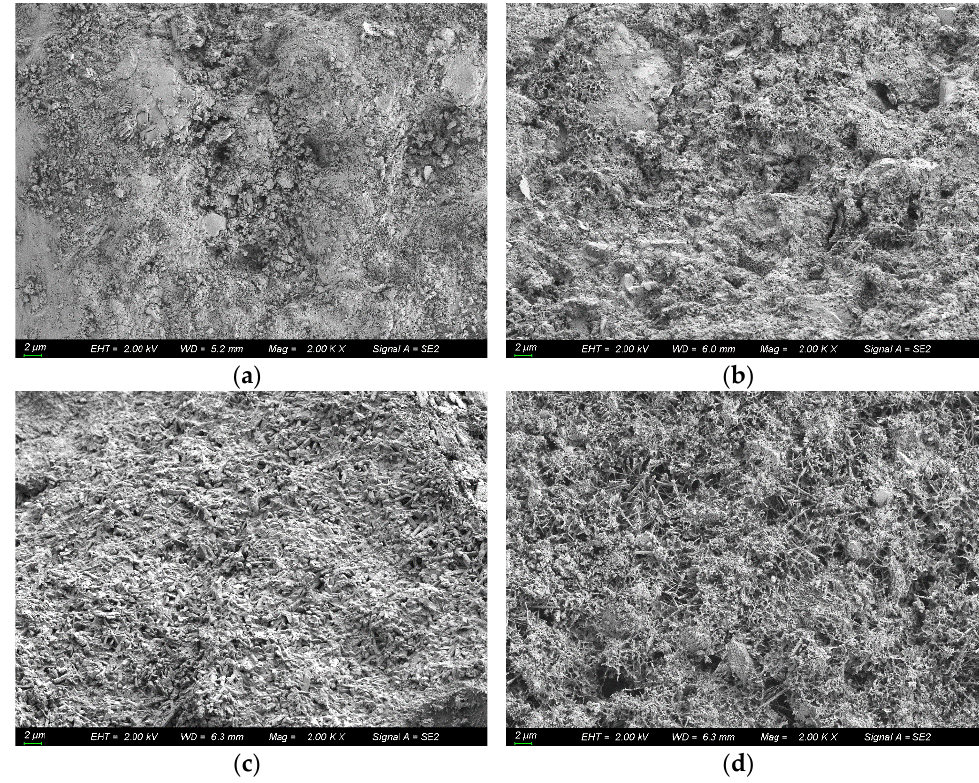
Figure 12. Microscopic morphological structure of coral concrete with water–cement ratio of 0.35. ( a ) t = 30 d; ( b ) t = 60 d; ( c ) t = 90 d; ( d ) t = 180 d. ( a ) t = 30 d; ( b ) t = 60 d; ( c ) t = 90 d; ( d ) t = 180